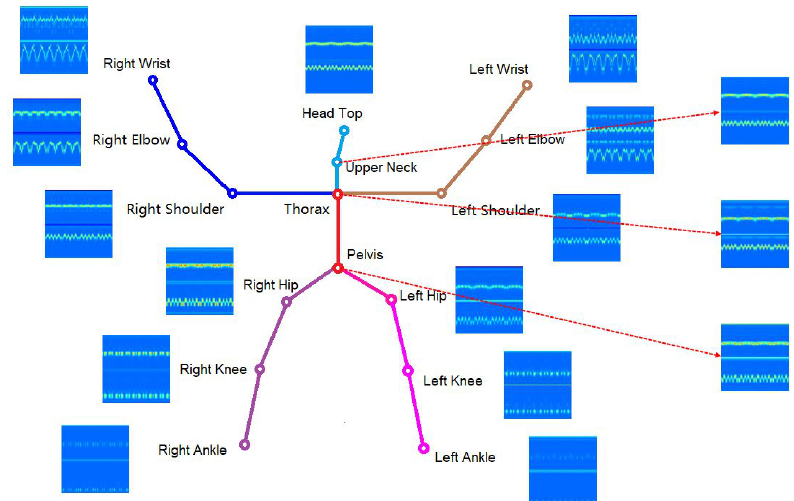
Figure 3. An example of processed heatmaps of a multi-period video. The example is based on an 8-cycle ’Jumping jack’ exercise video. There are 16 joints in total. Each joint corresponds to a heatmap figure representing the joint motion in the whole